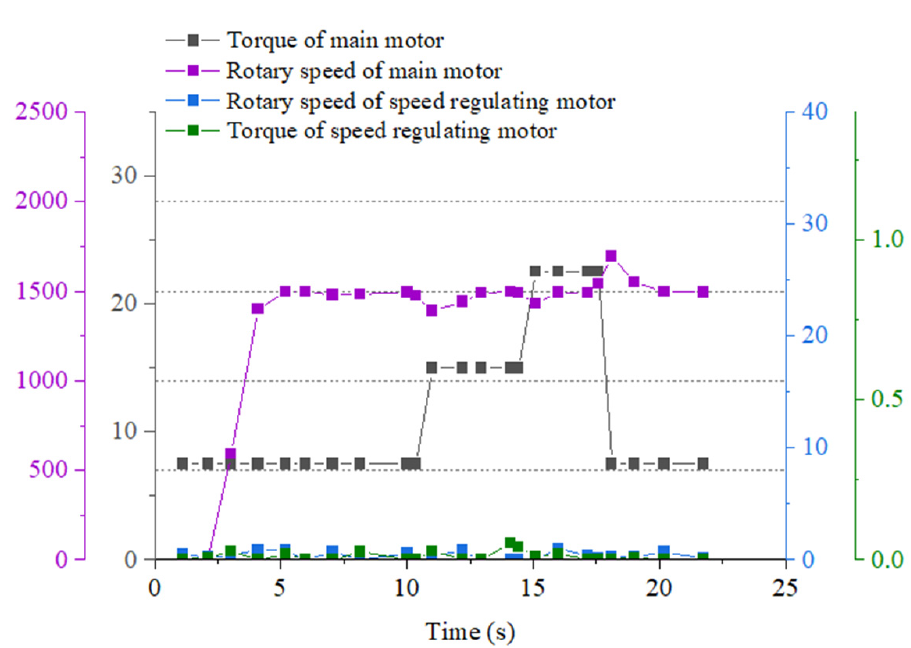
Figure 16. Speed and torque curves of main motor and speed control motor.